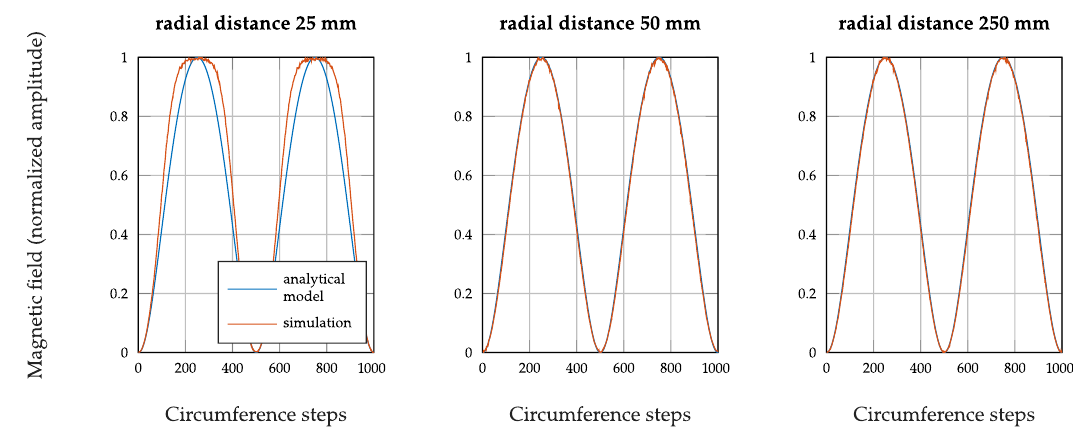
Figure 4. Comparison between the simulated magnetic field shape of the transmitter coil and the analytically calculated one.